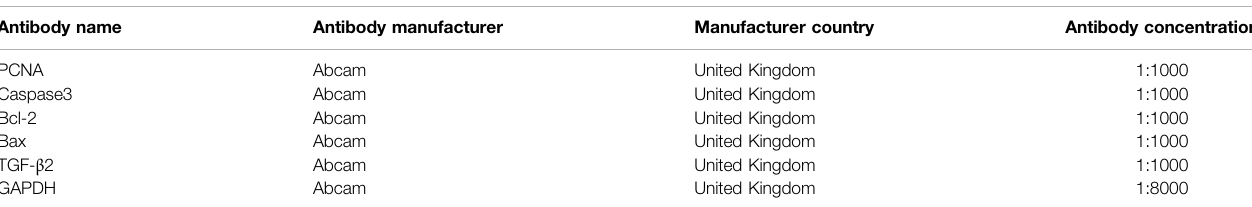
TABLE 2 | Antibody